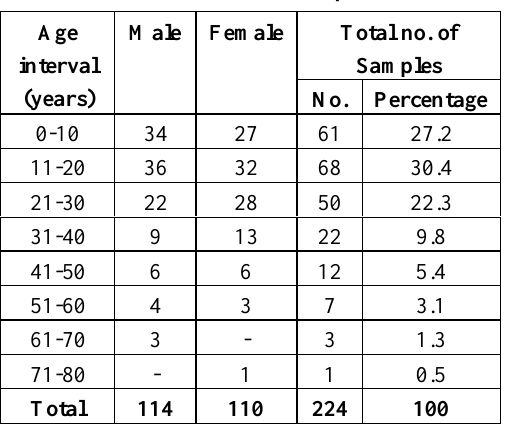
Table II : Correlation between Direct